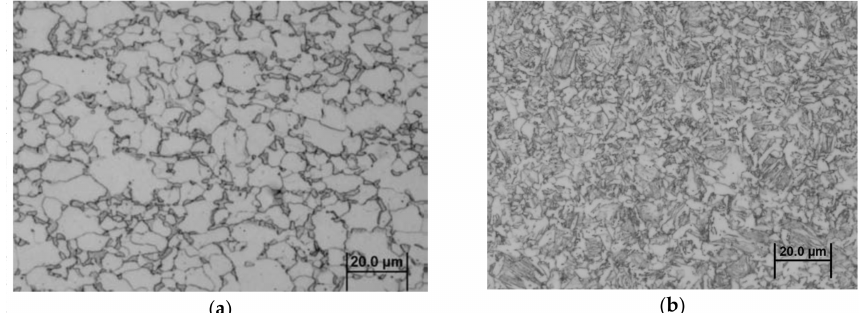
Figure 4. The microstructure of material A after annealing: ( a ) DPA 740 ; ( b ) DPA 840 .